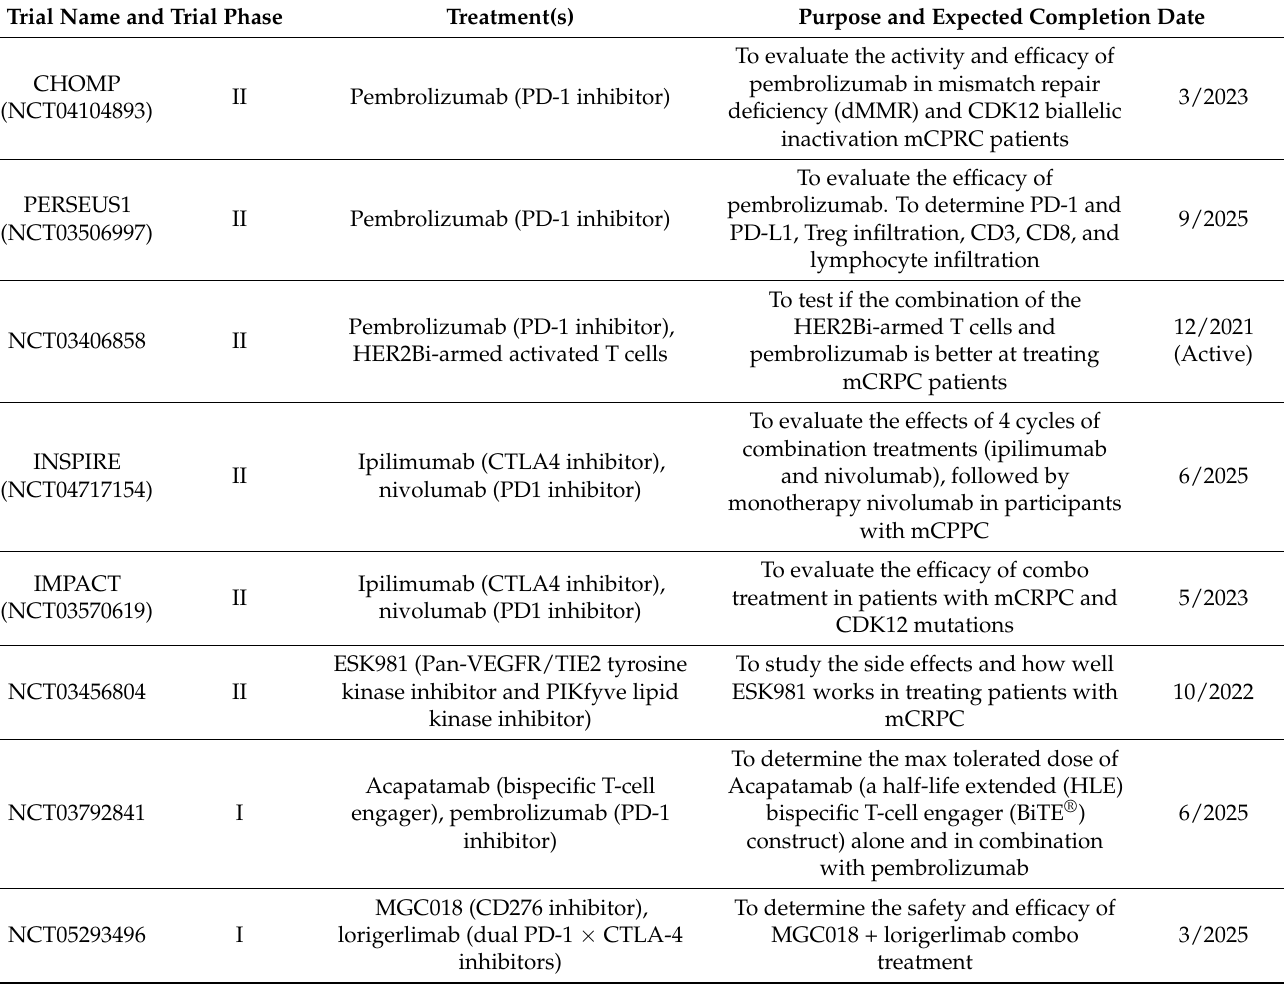
Table 2. Ongoing clinical trials utilizing immune checkpoint inhibitors in CRPC